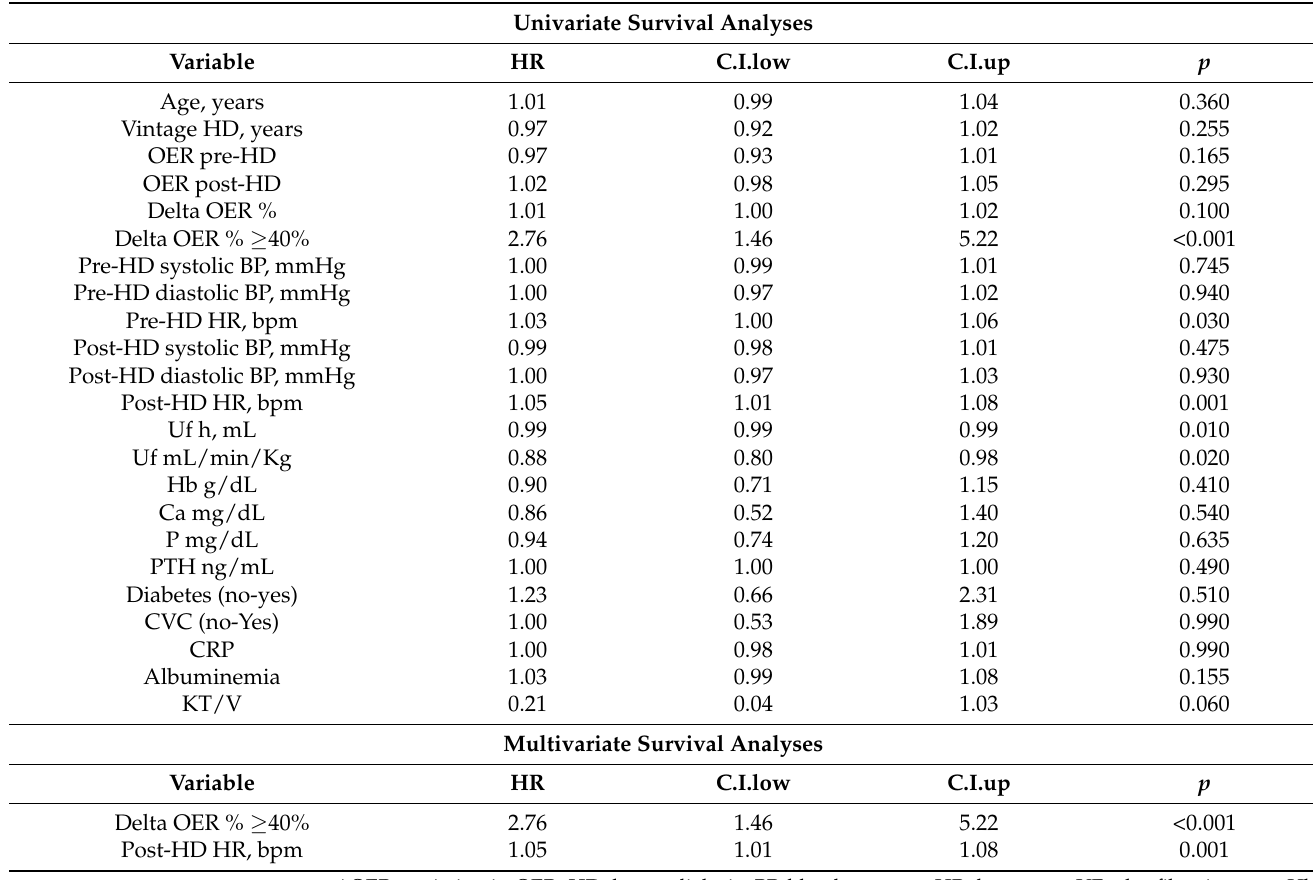
Table 2. Univariate and multivariate survival analysis of the enrolled population (N = 101).